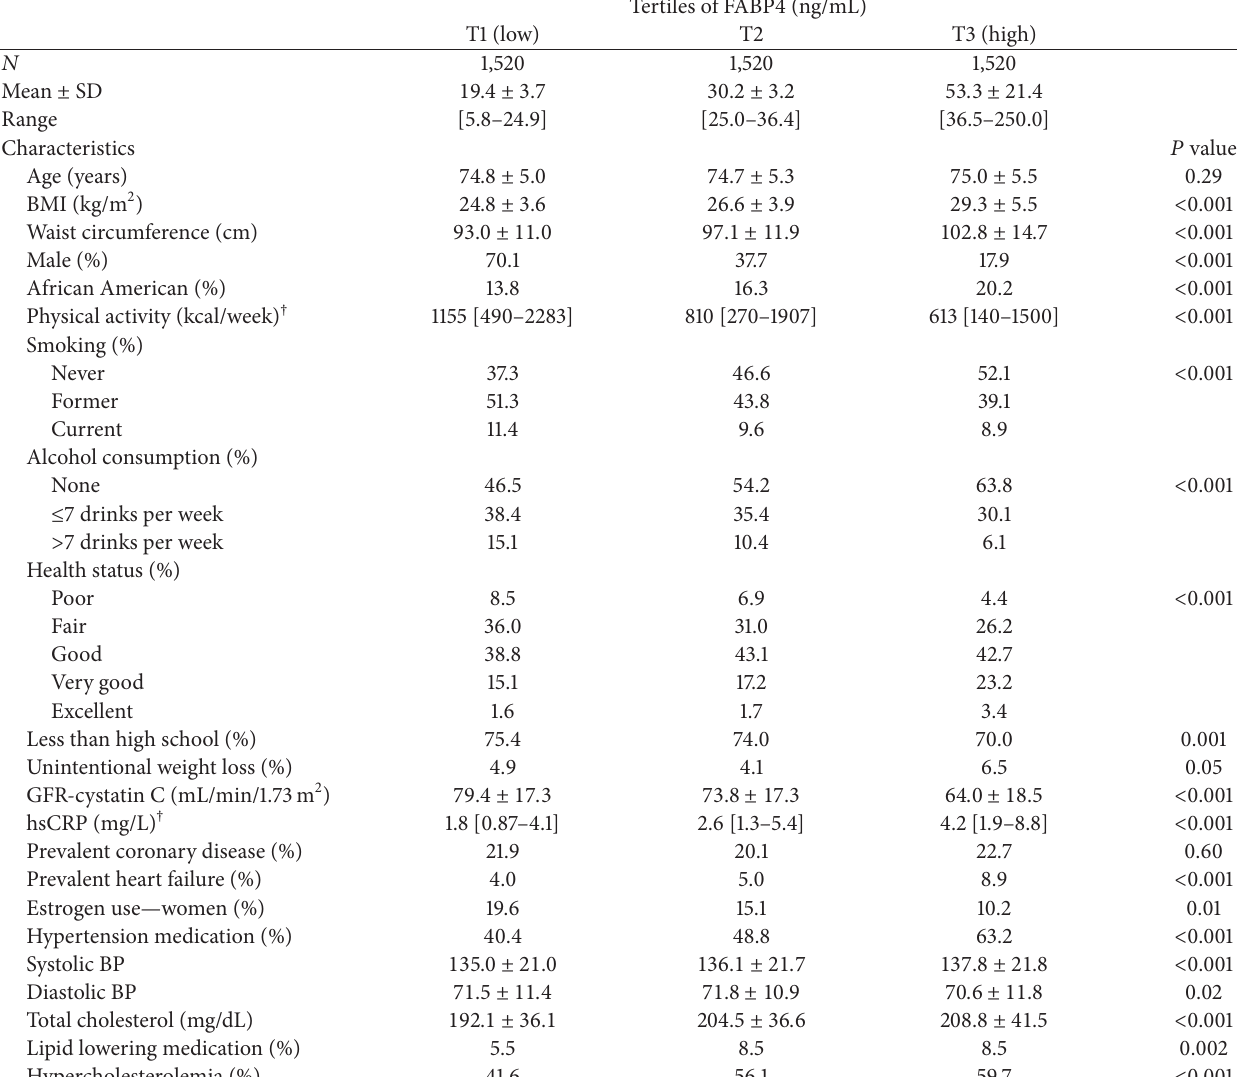
Table 1: Baseline characteristics of the 4,560 participants according to tertiles of